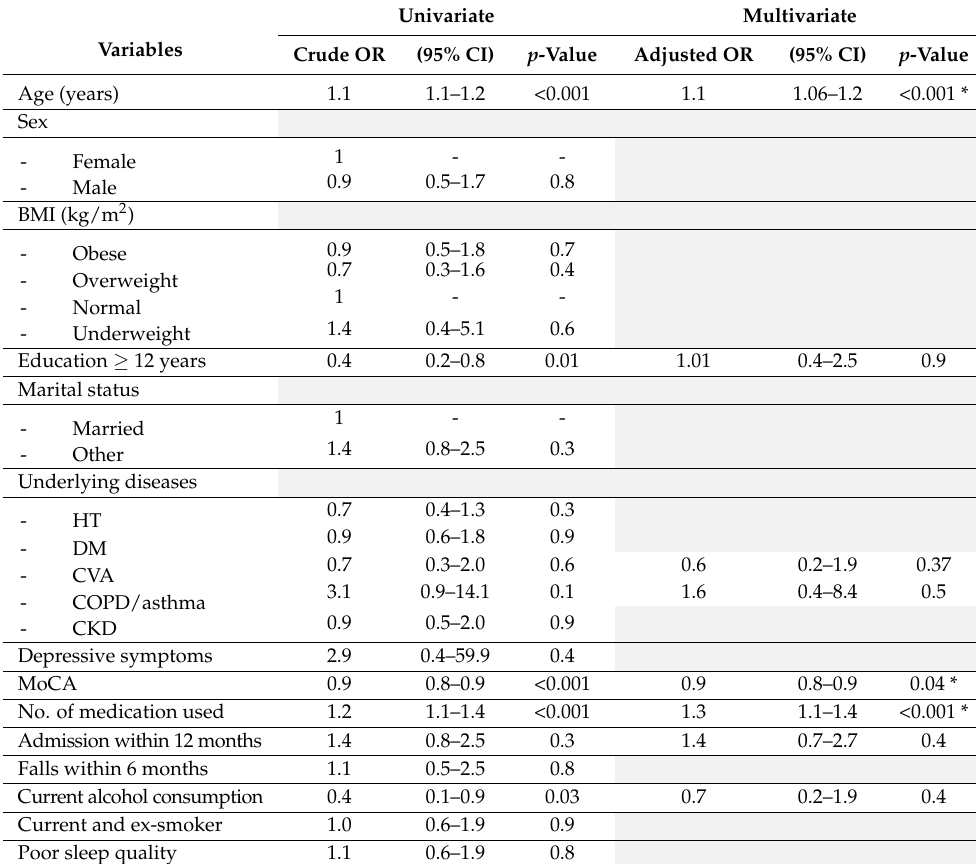
Table 2. Factors associated with low HGS according to univariate and multivariate analysis.